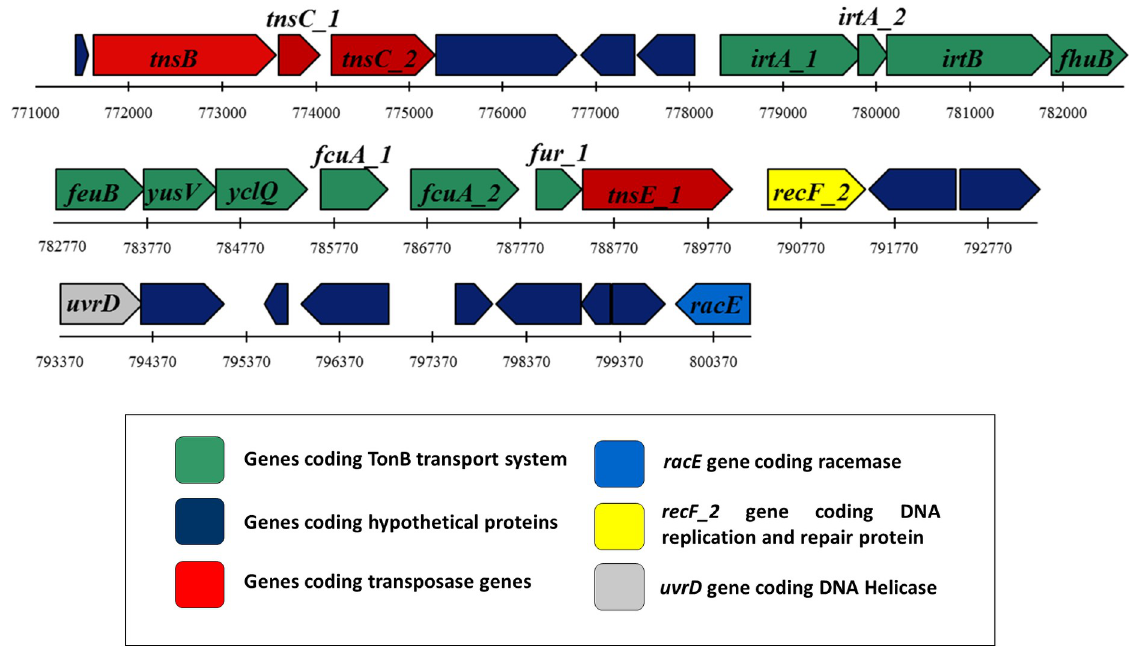
Fig 8. Genomic Island. The genetic map indicates the genomic island (30Kb) identified in the genome of DS002 with putative iron acquisition machinery. Genes coding a TonB transport system and hypothetical proteins are shown with dark green and blue arrows, respectively. The genetic map also indicates the presence of tnsB , tnsC _1, tnsC _2, tnsE _1 encoding a transposase (red), along with uvrD (grey), racE (light blue) and recF2 (yellow) encoding DNA helicase, racemase, and a DNA replication/repair protein, respectively.